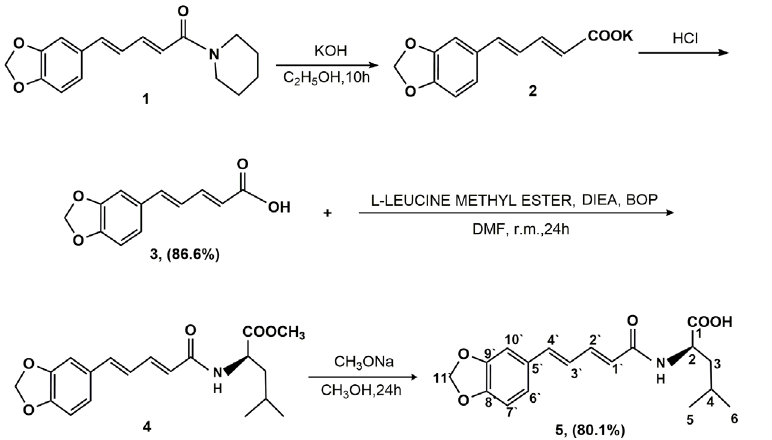
Fig. 1. Synthetic route of N-leucinylpiperamide